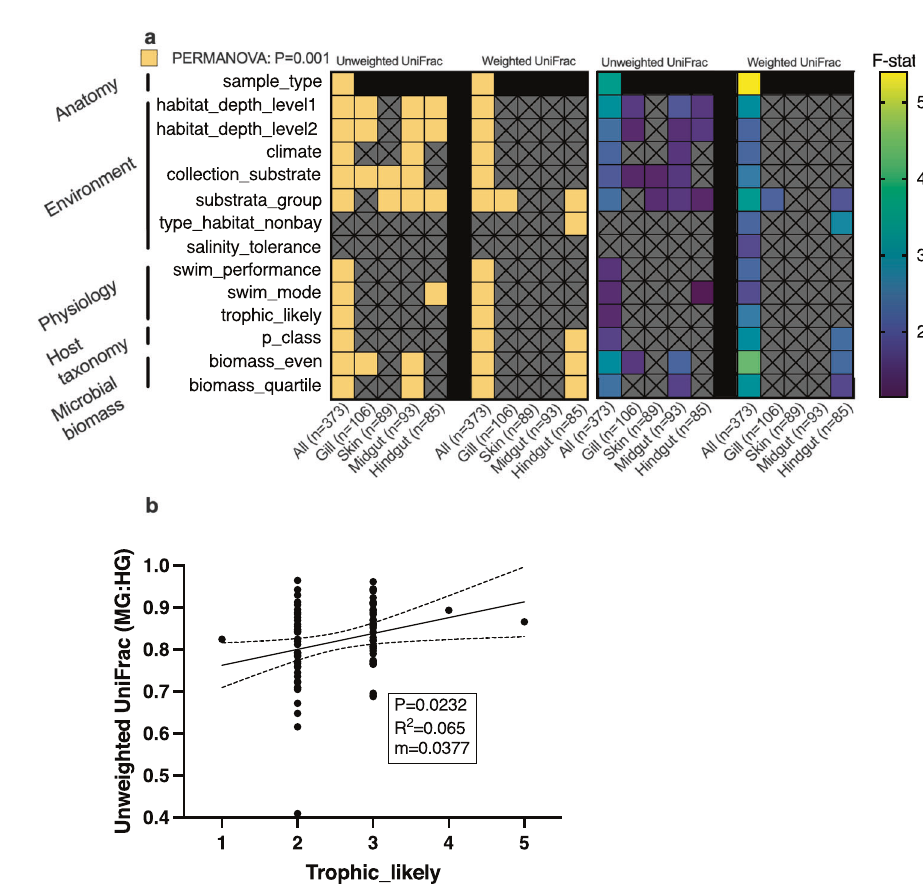
b Impact of trophic level on similarity between midgut and hindgut (within a species)(linearmodel: pp value,mslope,dottedlinesare95%con fi denceinterval). F-Stat test statistic used in PERMANOVA analysis, all row names in a are metadata column names used in the analysis, MG midgut, HG hindgut, Gen. Weighted Uni- Frac generalized weighted